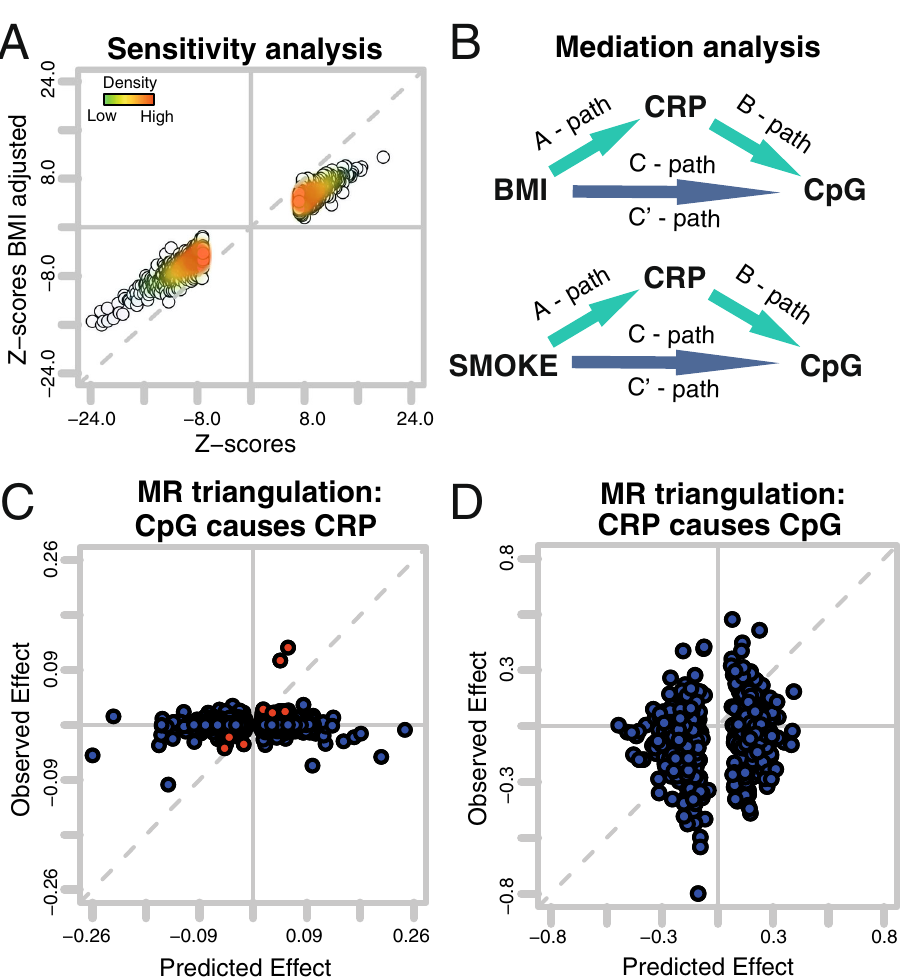
Fig. 3 Driving forces of CpG signature. Panel A is a comparison of Z-scores from the sensitivity analysis. Each dot represents a coef fi cient from the 1511 CRP-associated loci. The X -axis gives Z-scores derived from base model as applied in multi-ethnic meta-analysis. The Y -axis gives results from the same analysis adjusted for BMI. Panel B gives an overview of applied mediation analysis models. Panels C and D are representations of the Mendelian Randomization triangulation analysis. Each dot represents a CpG. The Y -axis is the observed effect, which is the association between the genetic instrument and outcome. The observed effects for Panel C originate from CpG instruments (SNPs) vs serum CRP levels. The predicted effect is the combined effect from the SNP CpG association and the CpG serum CRP association. Observed effects for D are the associations between a polygenic risk score for CRP (instruments) and CpG methylation. The predicted effects for panel D are the combined effects from the polygenic risk score for CRP (instruments) serum CRP association and serum CRP CpG methylation association (CRP Genetic risk score for CRP association × CRP CpG association ). The observed effect is the association of the polygenic risk score for CRP (instruments) to CpG methylation (CRP Genetic risk score for CpG association